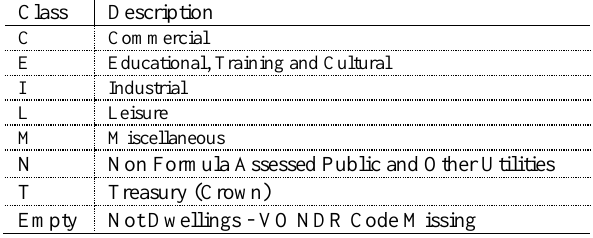
Table 7. A summary for classification of addresses in